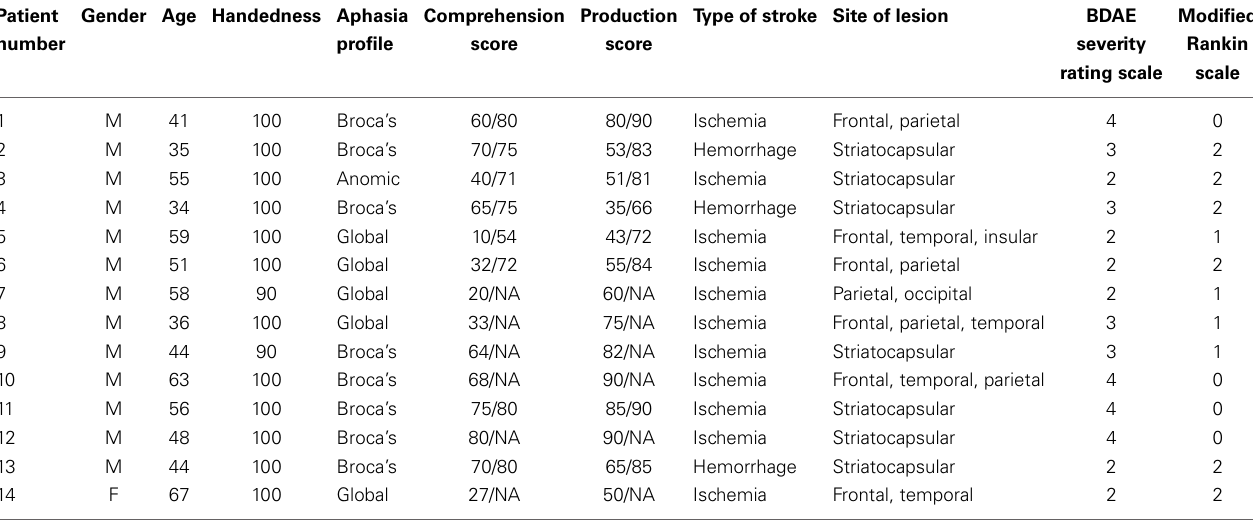
Table 2 | Patient characteristics and subtest results of the CRRCAE at time point one and two. Patient Gender Age Handedness Aphasia Comprehension Production Type of stroke Site of